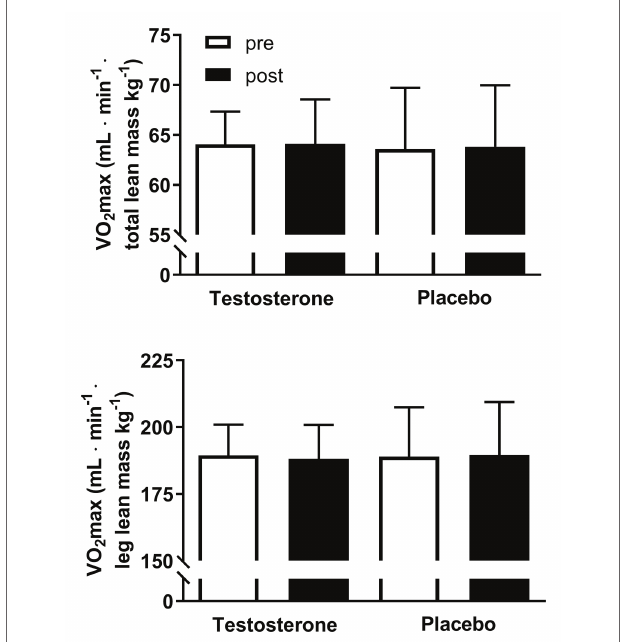
FIGURE 2 | Maximal oxygen consumption (VO 2 max) adjusted for total and leg lean mass pre (white bars) and post (black bars) 10 weeks of either 10 mg of testosterone cream daily ( n = 24) or placebo ( n = 24). VO 2 max is presented as the mean ± SD and in ml min −1 lean mass kg −1